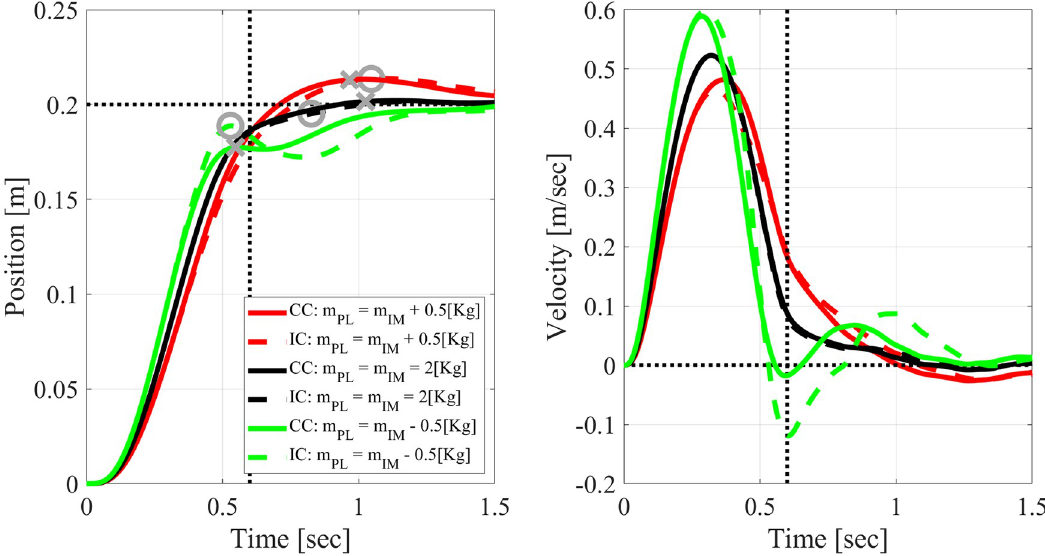
Fig 6. Effect of inaccurately modeled mass on simulated reaching movements with measurement delay τ = 0.15[sec]. Solid: CC. Dashed: periodic IC with h = 0.2[ sec ]. The mass of the plant, m PL , is either accurate (black), lighter (green), or heavier (red) than the = 2[ Kg ]. Left: position. Right: velocity. Vertical dashed lines mark the desired duration of mass of the internal model, m IM movement, T = 0.6[sec]. Horizontal dashed line marks the target position. Crosses and circles mark the positions from which dysmetria was evaluated for CC and IC, respectively (see